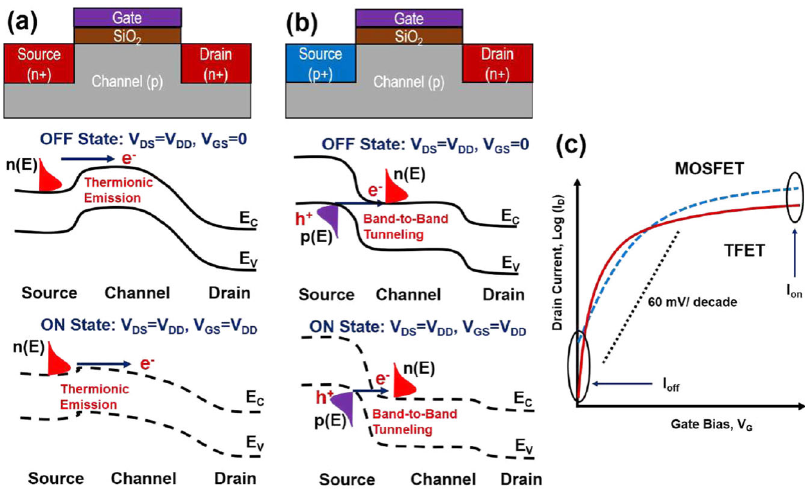
Fig. 1 Working Principle of TFET. The energy band diagram of a MOSFET, b TFET for ON-state and OFF-state conditions, and c comparative transfer characteristics of well-designed MOSFET and TFET. c Schematic representation of BTBT in the tunneling junction of TFET.